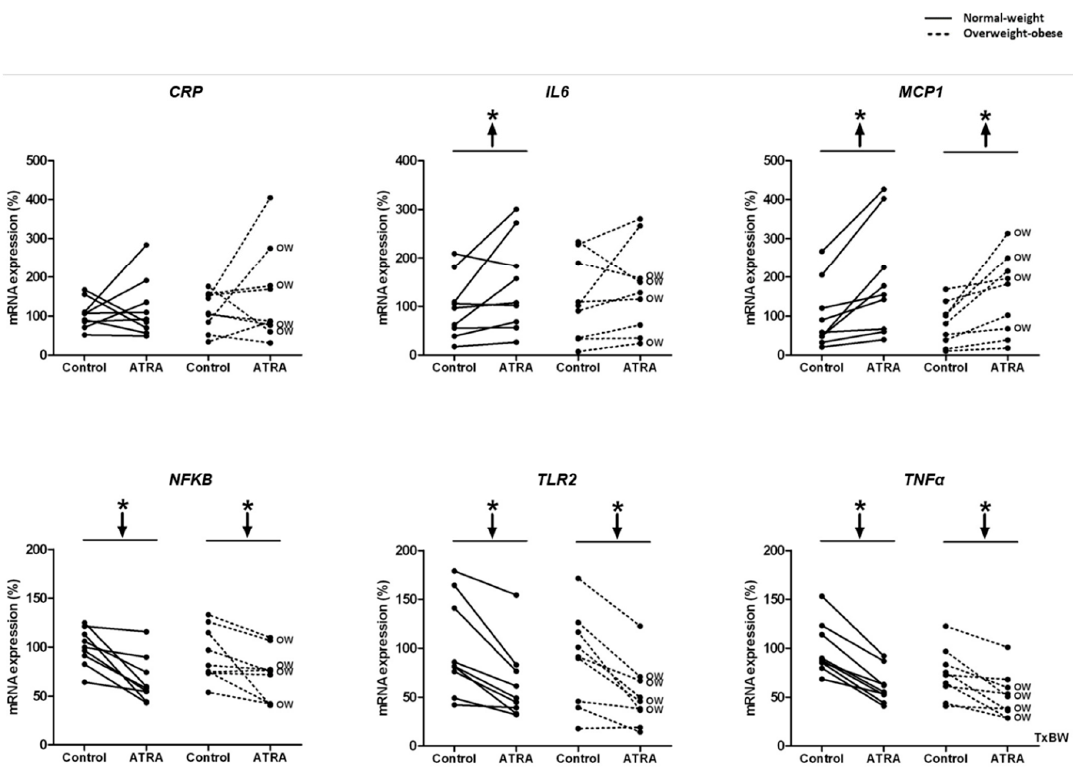
Figure 3. Effect of ATRA treatment on mRNA expression of gene expression of the inflammatory genes: CRP , IL6 , MCP1 , NFKB , TLR2, and TNF α in isolated PBMCs from NW and OW-OB individuals,